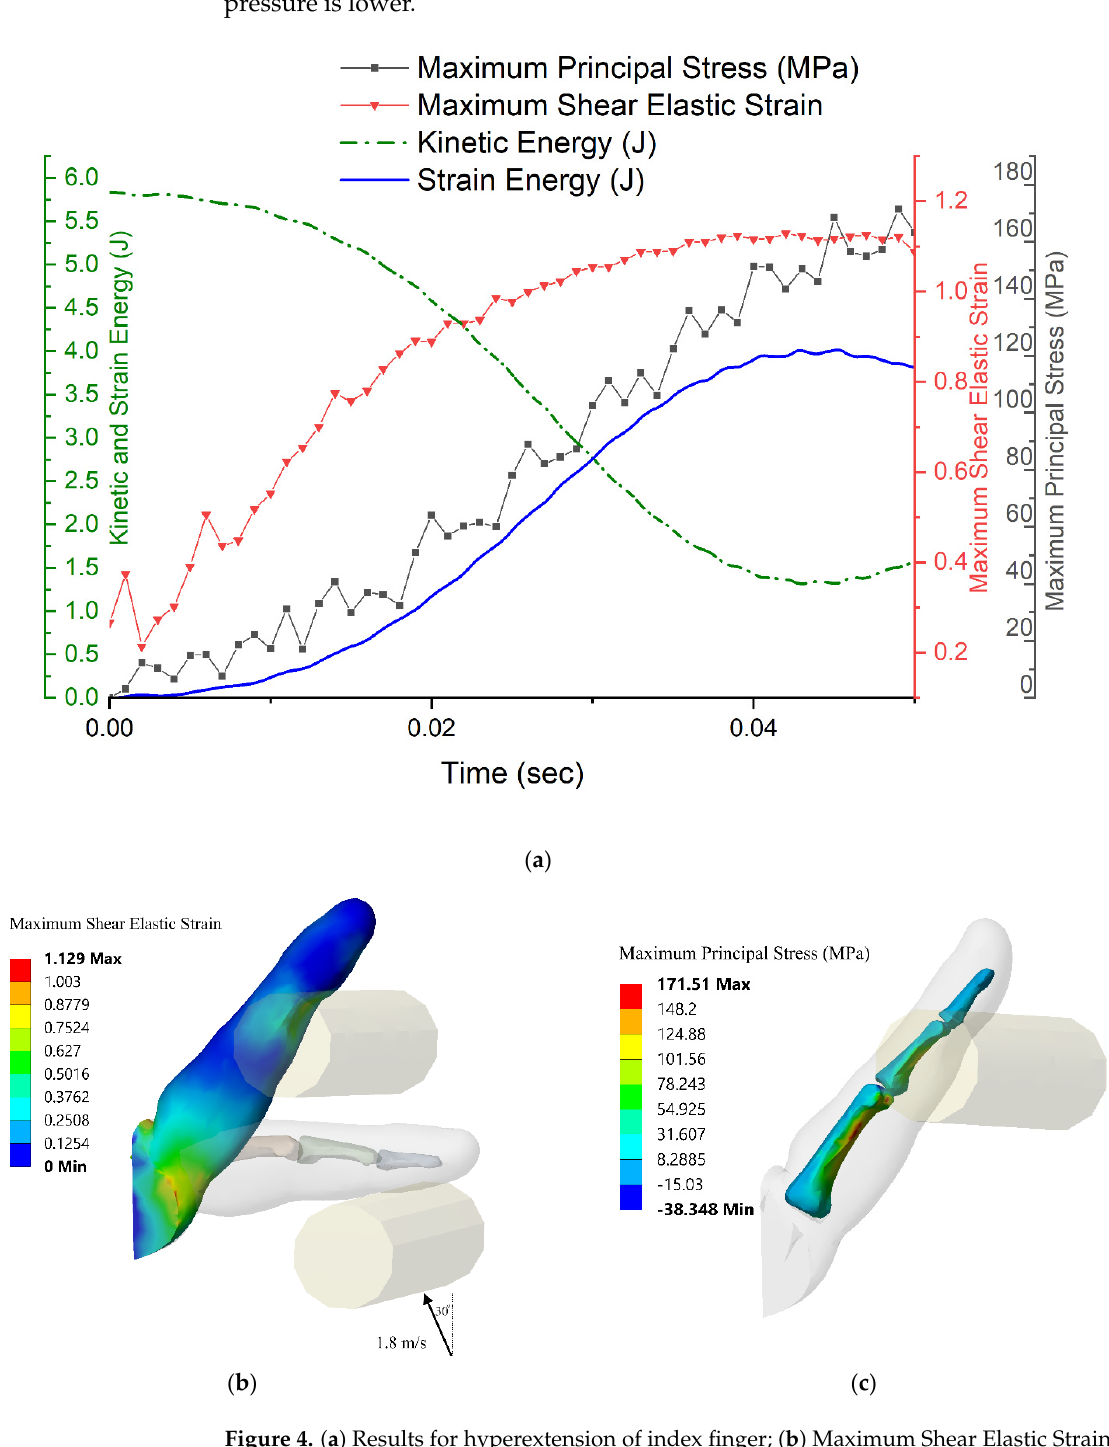
Figure 4. ( a ) Results for hyperextension of index finger; ( b ) Maximum Shear Elastic Strain; ( c ) Maximum Principal Stress.